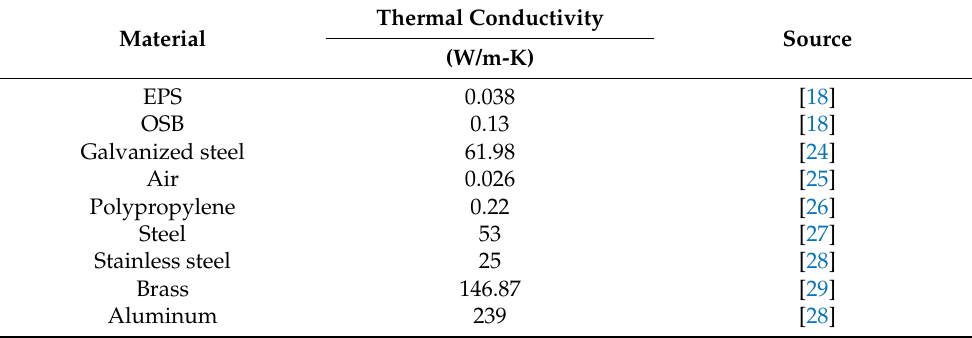
Table 1. Thermal conductivities of constituent materials of the SIP